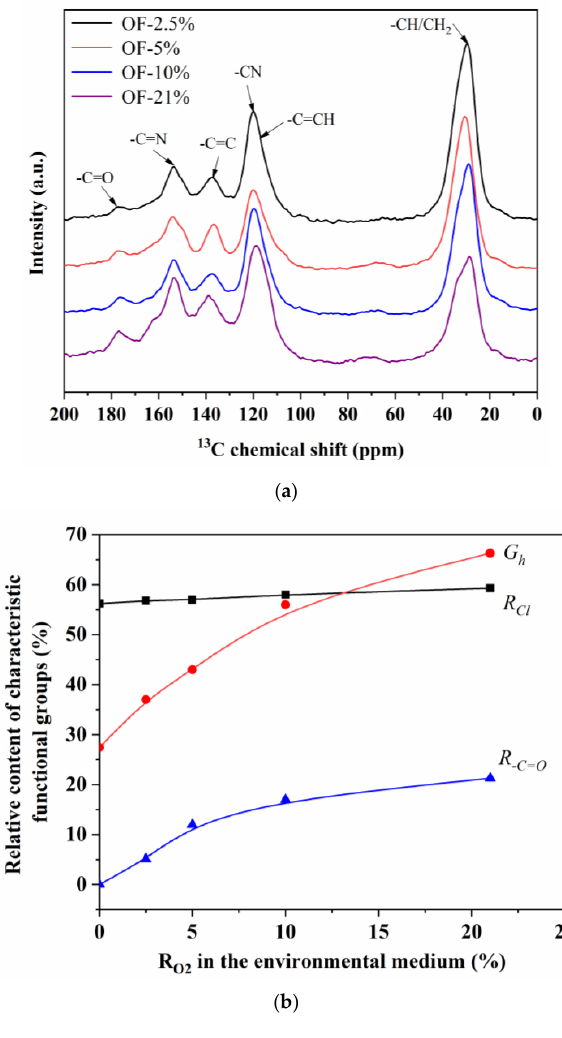
Figure 8. The 13 C-NMR characterization of chemical structure evolution of pre-oxidized fibers. ( a ) the 13 C-NMR spectrum and ( b ) relative content of characteristic functional